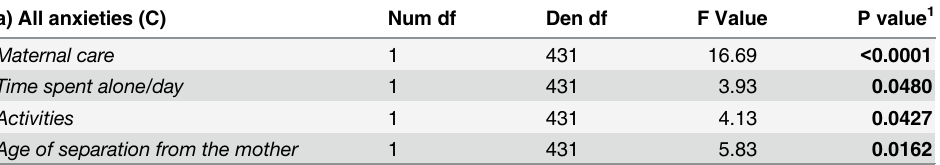
Table 5. Generalized linear mixed model analysis results on the association between environmental factors and comorbid anxieties. a) All anxieties (C) Den df F Value P value